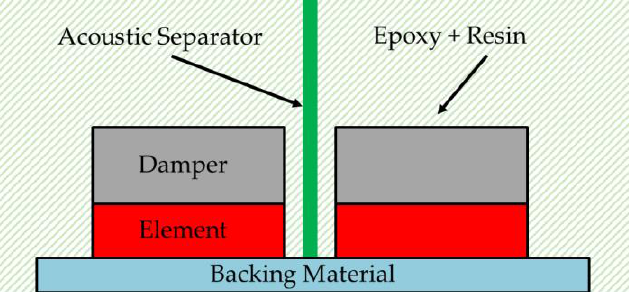
Figure 9. Images of phased array probe with a flexible structure geometry: The cross-section of T/R probe.